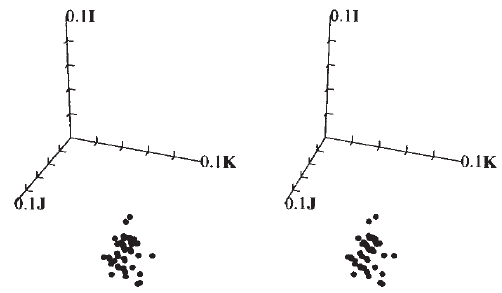
Figure 3. Scatter plot of 50 measurements of refractive state of a test eye obtained using a Nidek ARK-700 autorefractor. An increased amount of antistigmatic variation is seen. Operator refocused the instrument after each measurement and decided when to trigger the measurement. Length of axes: 0.1 D. For details see text.